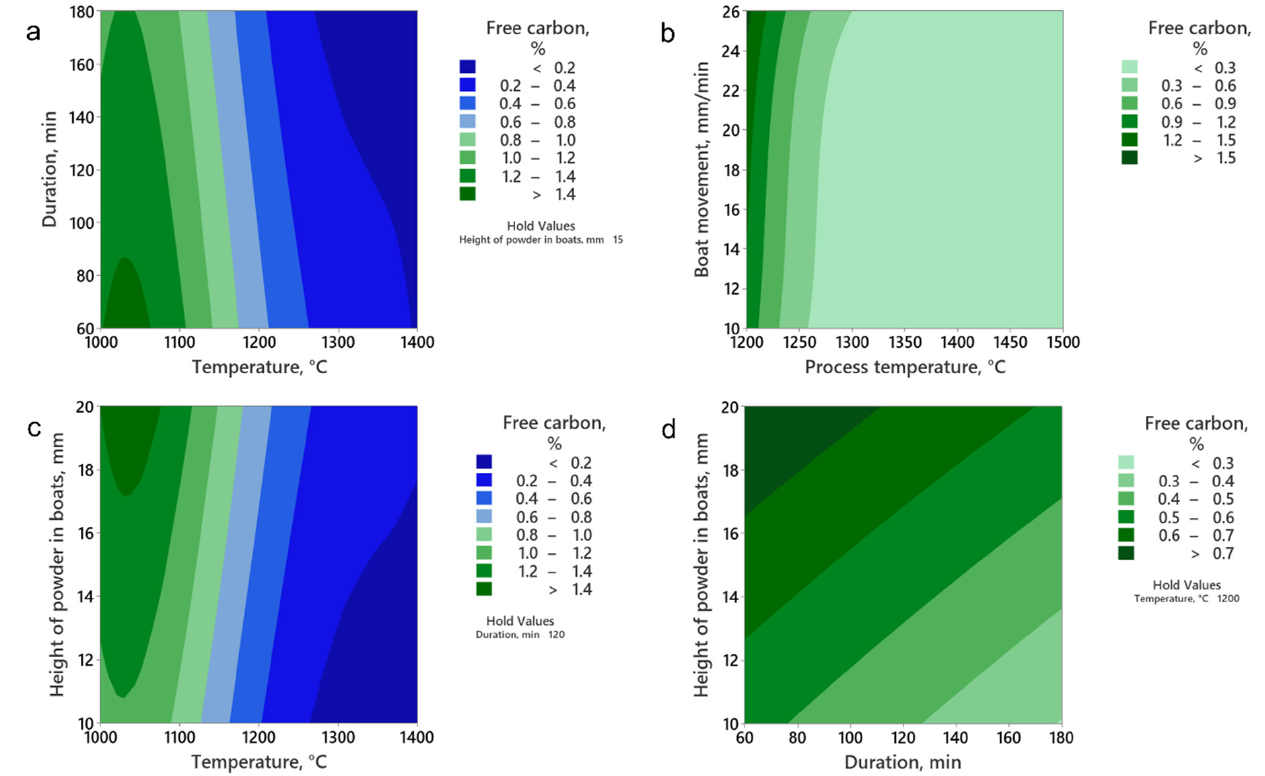
Figure 5. Two-parameter interaction plots for the free carbon content in WC after annealing in a furnace. Interaction plots represent the combined influence of duration and temperature ( a ), boat movement and process temperature ( b ), the height of powder in boats and temperature ( c ), the height of powder in boats, and duration ( d ).